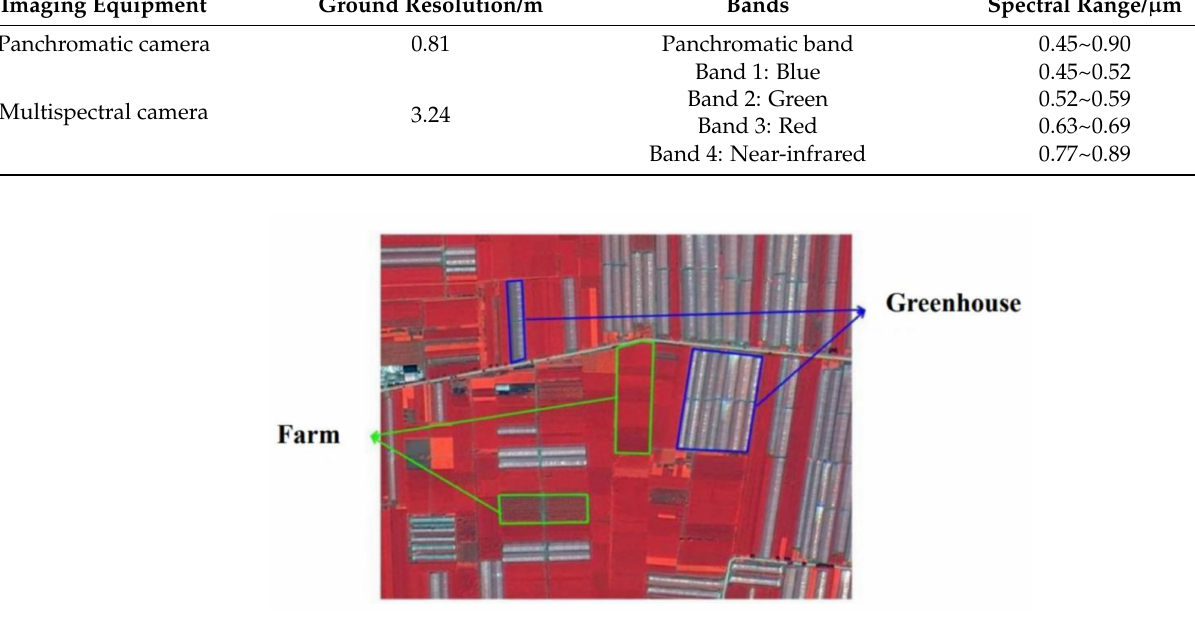
Figure 2. False color image of the study